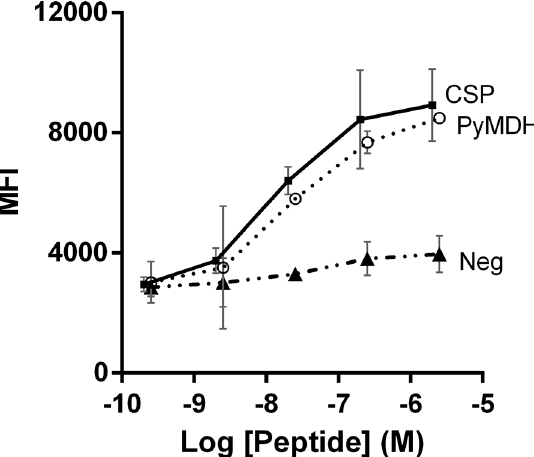
Fig 4. The PyMDH epitope binds to murine H2-K d . RMA/S cells expressing H2-K d were incubated with peptides for PyCSP (squares), PyMDH (circles) or non-specific peptide. PyCSP and PyMDH peptides stabilized H2-K d , indicative of specific MHC binding. Error bars indicate the 95% confidence interval.